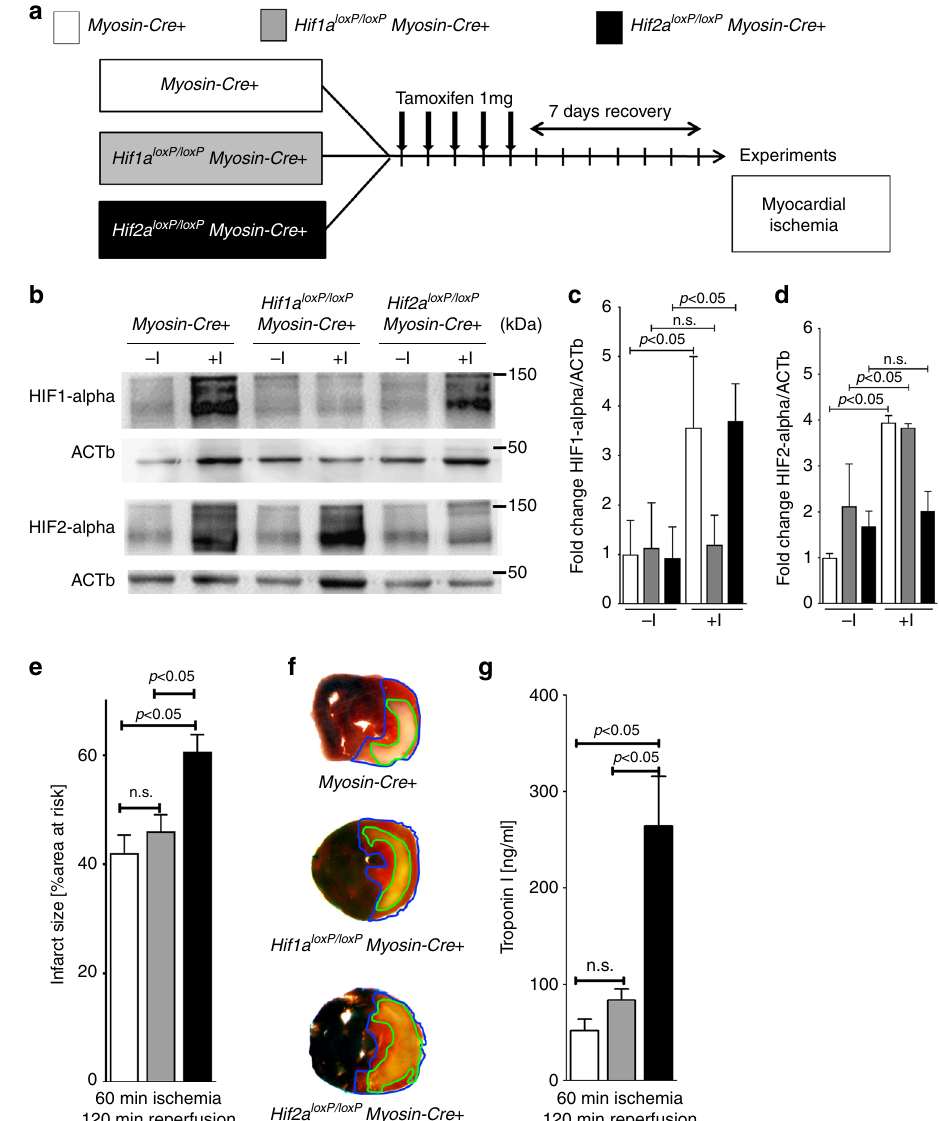
Fig. 1 Contribution of myocyte-speci fi c hypoxia-inducible factor (HIF) isoforms Hif1a or Hif2a to cardioprotection. a Schematic of breeding approach to generate mice with induced myocyte-speci fi c HIF deletions used in subsequent studies. Hif1a loxP/loxP or Hif2a loxP/loxP mice were crossed with Cre-recombinase expressing mice under the control of Myosin-heavy chain promoter ( Myosin-Cre +); these mice express cre-recombinase under the control of a tamoxifen-inducer. Control animals ( Myosin-Cre +), Hif1a loxP/loxP Myosin-Cre + or Hif2a loxP/loxP Myosin-Cre + received a daily dose of 1 mg i.p. Tamoxifen fi ve consecutive days to induce the Cre-recombinase activity. After 7 days, animals underwent experimental protocol (60 min of in situ myocardial ischemia followed by 120 min of reperfusion). b HIF1-alpha or HIF2-alpha immunoblot analysis from homogenized myocardial tissue, harvested from male Myosin-Cre + and Hif1a loxP/loxP Myosin-Cre + or Hif2a loxP/loxP Myosin-Cre + mice, matched in age and weight. Mice underwent a thoracotomy with no further treatment(-I) or 60 min of myocardial ischemia (+ I ) followed by 120 min reperfusion; β -Actin (ACTb) served as a loading control. One representative blot out of three experiments is shown. c , d Quanti fi cation by densitometry of the HIF-immunoblot results relative to ACTb. Data are expressed as mean fold change ± SD normalized to untreated myocardial tissue from Myosin-Cre + compared by one-way ANOVA followed by Bonferroni ’ s multiple comparison test ( n = 3 per group; c : F 5,12 = 6.74, p = 0.0033; d : F 5,12 = 21.85, p < 0.0001). e Infarct sizes ± SD in Myosin-Cre +, Hif1a loxP/loxP Myosin-Cre + or Hif2a loxP/loxP Myosin - Cre + mice, presented as the percentage to the area-at-risk after 60 min of ischemia, followed by 120 min of reperfusion ( Myosin-Cre + n = 5; Hif1a loxP/loxP Myosin-Cre + n = 5; Hif2a loxP/loxP Myosin-Cre + n = 4; per group mean ± SD; compared by one-way ANOVA followed by Bonferroni ’ s multiple comparison test; F 2,11 = 7.901; p = 0.0075). f Representative infarct staining from Myosin-Cre +, Hif1a loxP/loxP Myosin-Cre + or Hif2a loxP/loxP Myosin-Cre +. g Troponin serum levels after 60 min ischemia, followed by 120 min of reperfusion in Myosin-Cre + , Hif1a loxP/loxP Myosin-Cre + or Hif2a loxP/loxP Myosin-Cre + ( Myosin-Cre + n = 5; Hif1a loxP/loxP Myosin-Cre + n = 5, and Hif2a loxP/loxP Myosin-Cre + n = 4 per group; presented as mean ± SD; compared by one-way ANOVA followed by Bonferroni ’ s multiple comparison test; F 2,11 = 19.14, p =